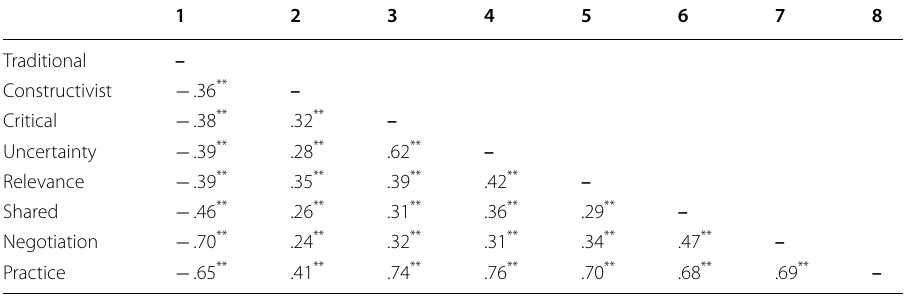
** . Correlation is significant at the 0.01 level